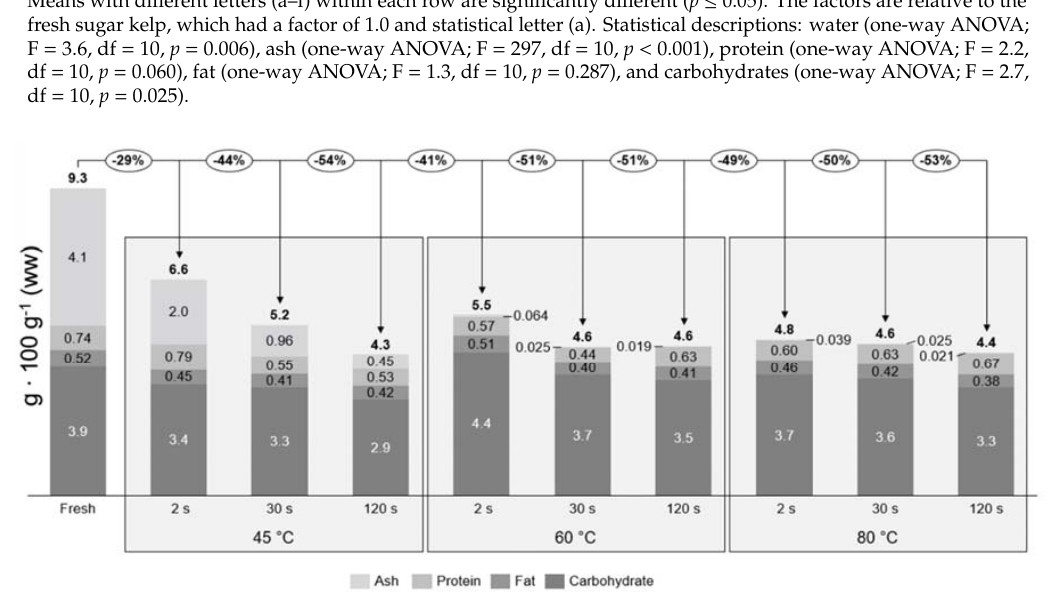
Figure 2. Mass balances for the proximate composition relative to the fresh sugar kelp for each blanching treatment. The percentages in circles describe the total loss of the proximate composition (excluding water). The concentration of each proximate is described by the bar diagram and the bold number above the bars are the total proximate composition relative to wet